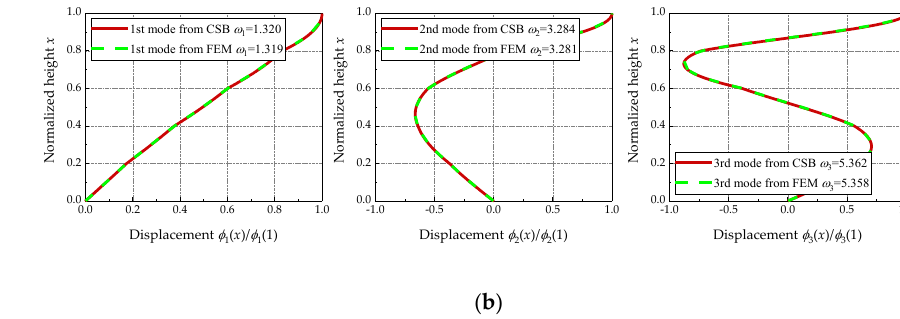
Figure 3. Validation of CSB model. ( a ) Stiffness distribution. ( b ) Comparisons for the first three modal shapes.